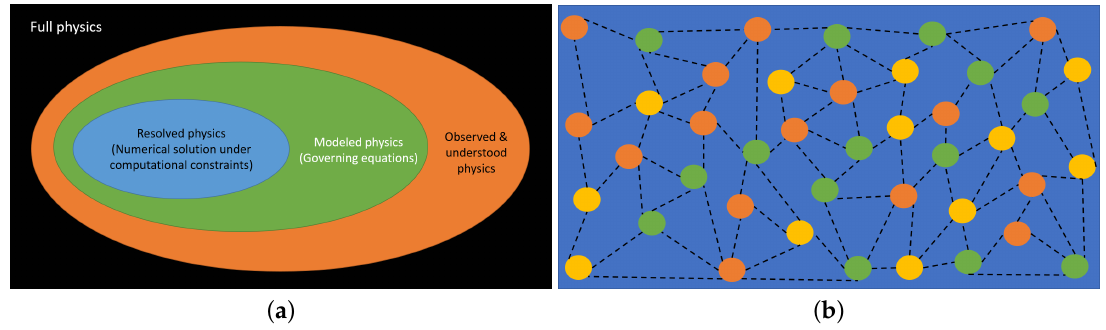
Figure 2. A schematic representation of the two distinct modeling approaches: ( a ) physics-based modeling approach; and ( b ) data-driven modeling